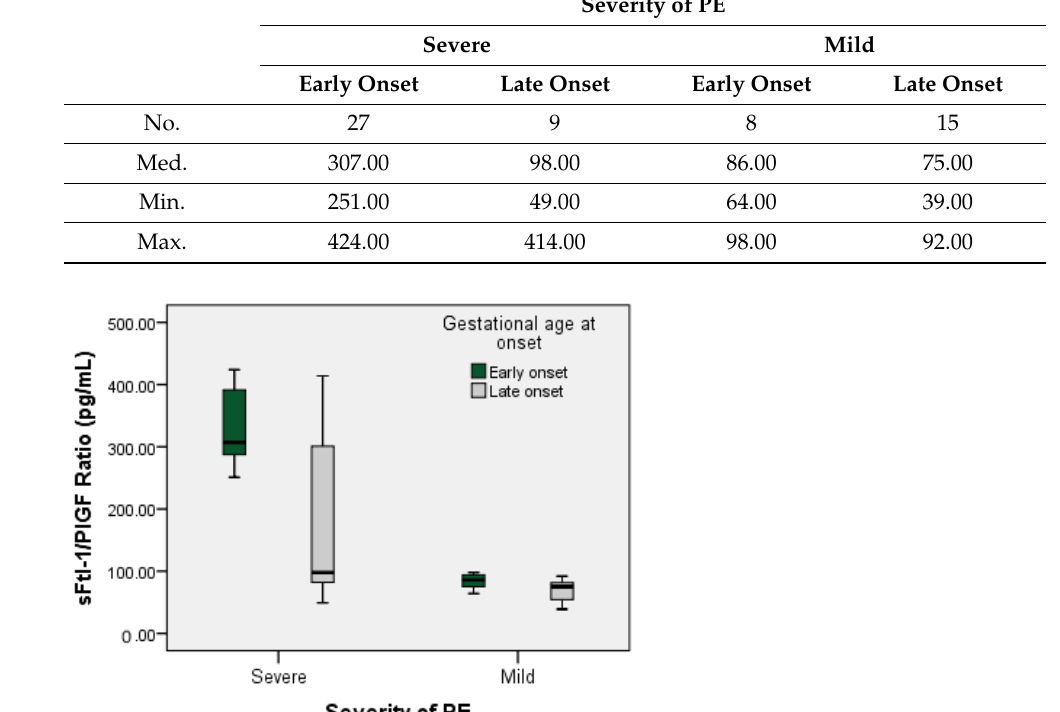
Table 7. Values of sFtl-1/PIGF ratio in PE depending on severity and onset.